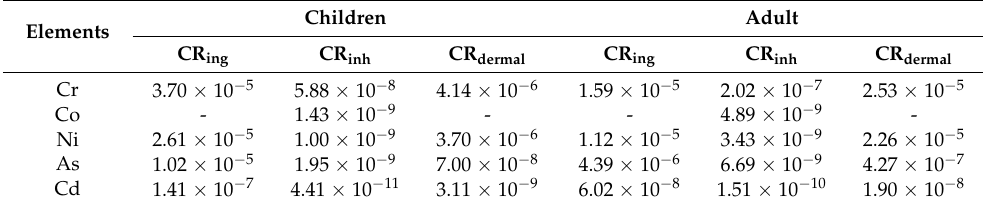
Table 7. CR ij for different intake route.